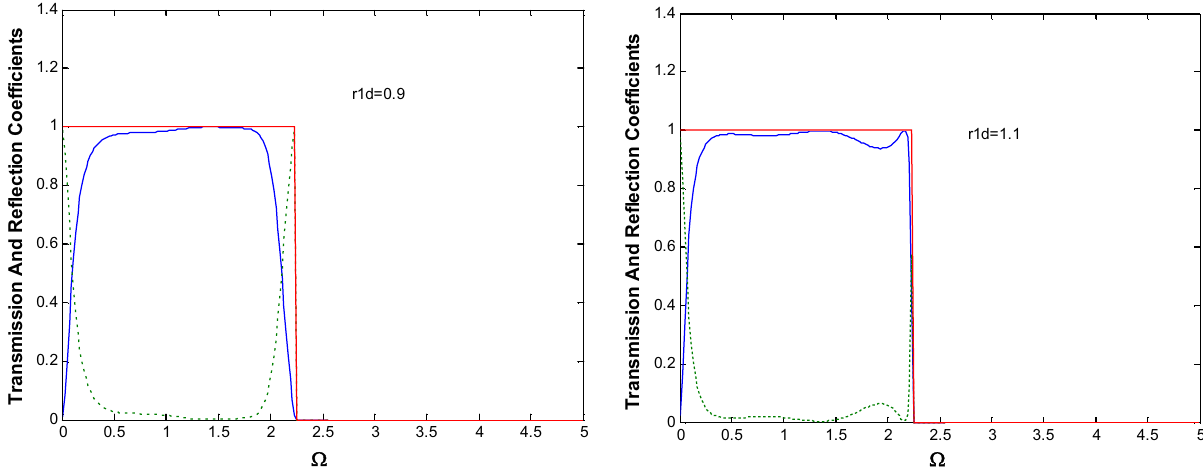
Figure 5: Transmission and re fl ection coe ffi cients in the case of softening mode 1.